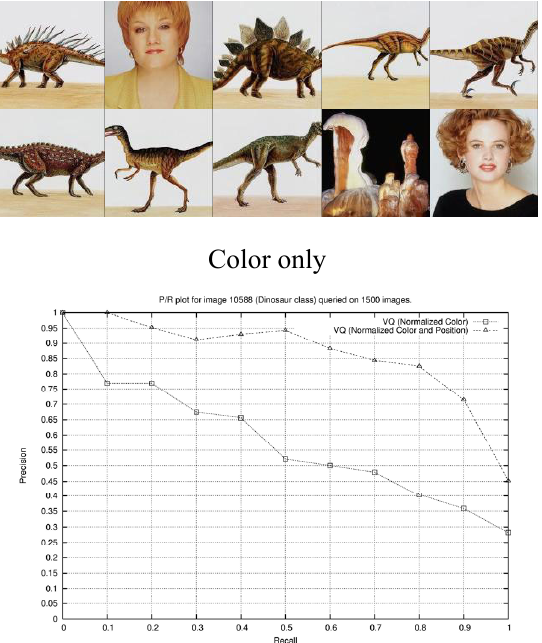
Average P/R (100 images) for the Dinosaur class, color vs.